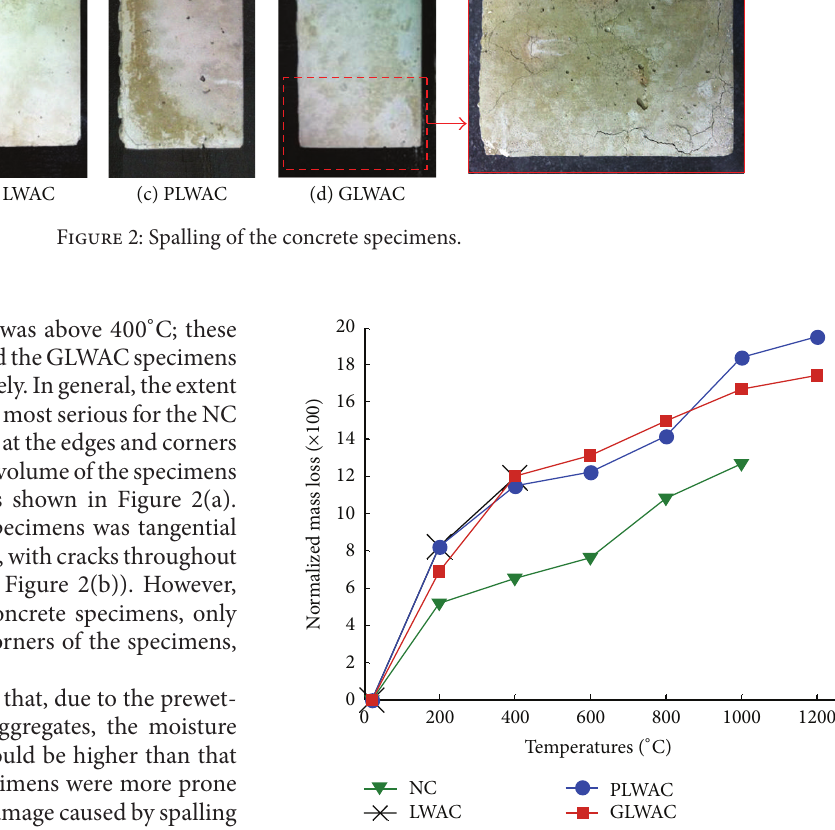
Figure 3: Mass loss of the specimens after being